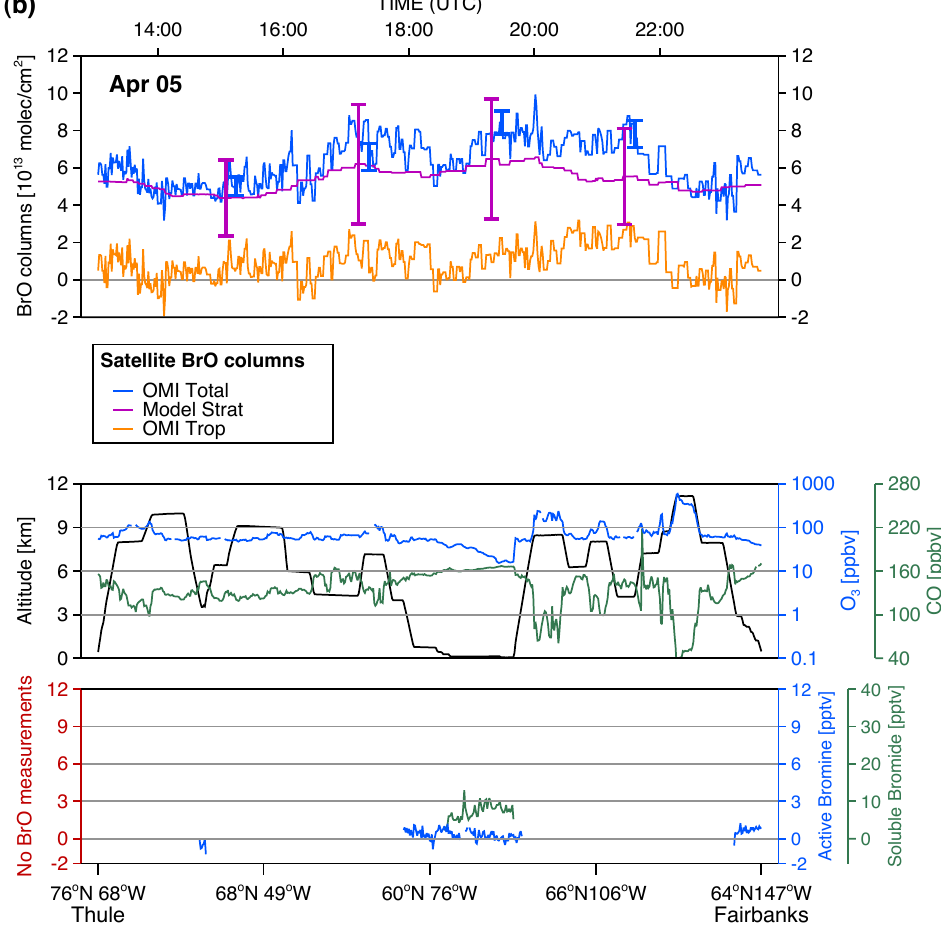
Fig. 7b. Similar to Fig. 6b but for the DC-8 flight on 5 April 2008. Aircraft in-situ BrO measurements are not available for this flight because BrO was below the detection limit.